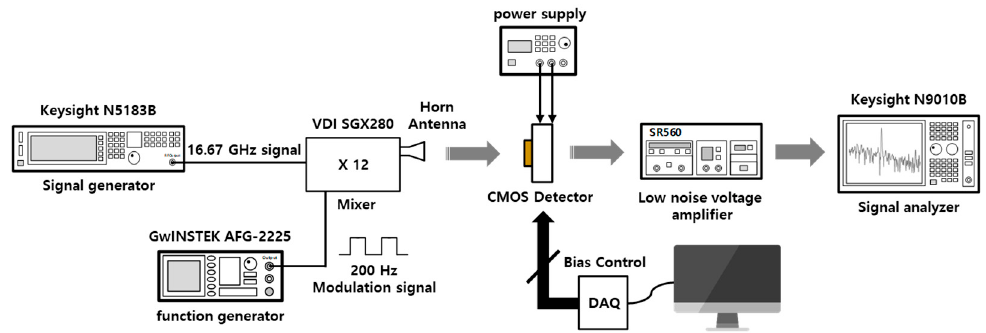
Figure 6. Measurement setup to obtain the detector performances.